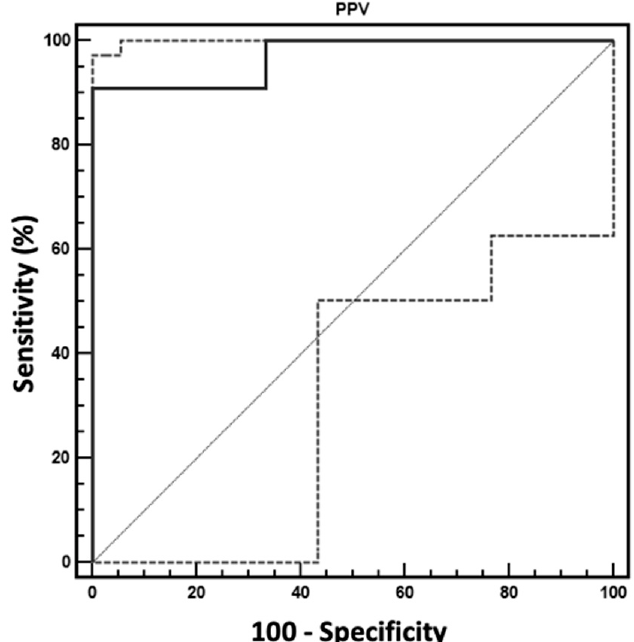
Figure 1. Graphical representation of the ROC curve to test the ability of pulse pressure variation (PPV) to discriminate between sensitive (S group = decrease in CI ≥ 15% after PP) and non-sensitive (NO-S) subjects after the creation of the pneumoperitoneum in dogs undergoing laparoscopic surgery.